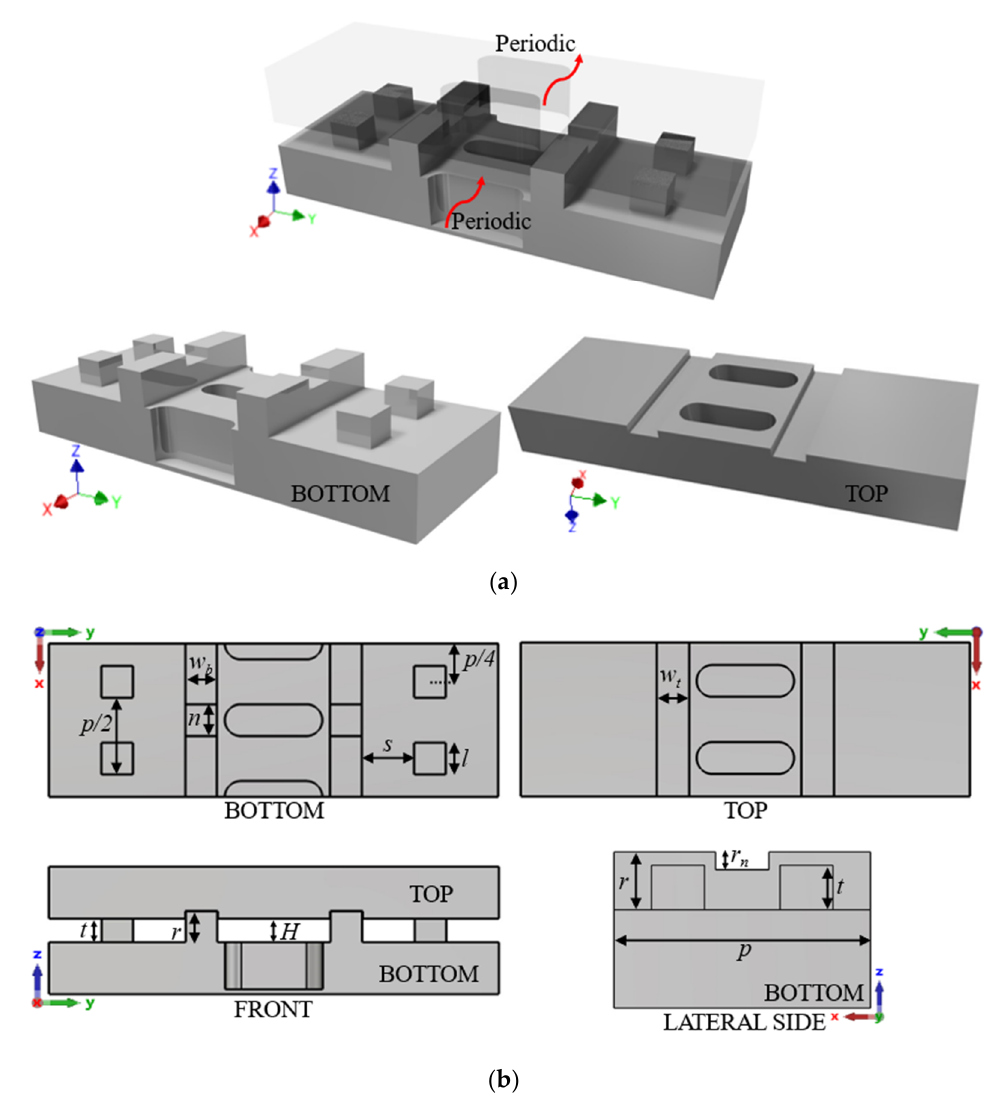
Figure 24. Double periodic glide-symmetric final unit cell. ( a ) Perspective view of the full structure with both top and bottom pieces and ( b ) top, front and lateral views of the complete unit cell. Table 3. Values of the parameters used in the design of the final unit cells with the sealing structure shown in Figure 24.